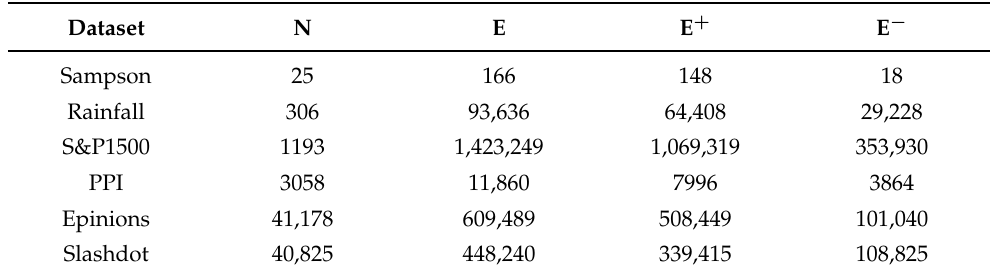
Table 1. Statistics of six real-world networks. E + and E − denote positive and negative links,